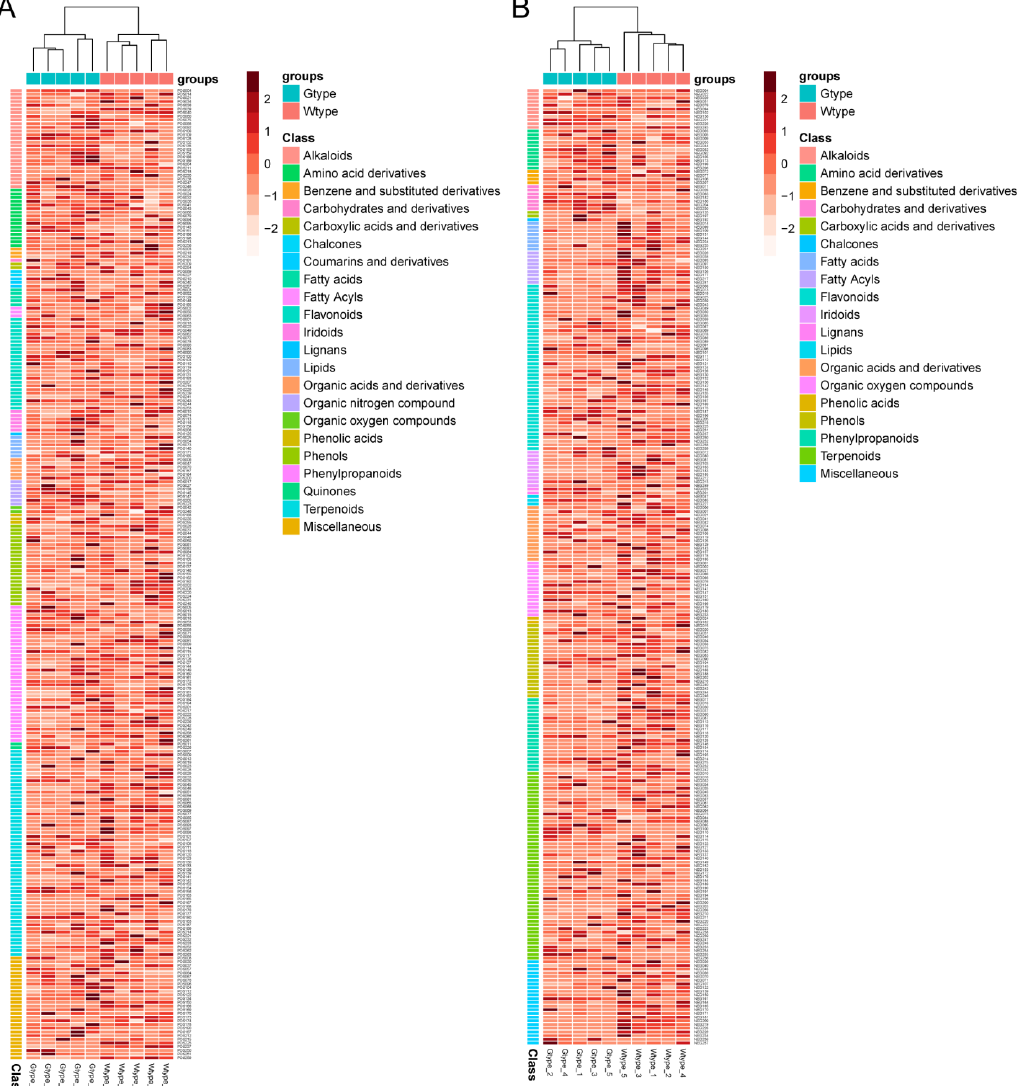
Figure 2. Heatmaps and hierarchical cluster analysis of the 263 tentatively identified metabolites acquired in positive ionization mode ( A ), and of the 258 tentatively identified metabolites acquired in negative ionization mode ( B